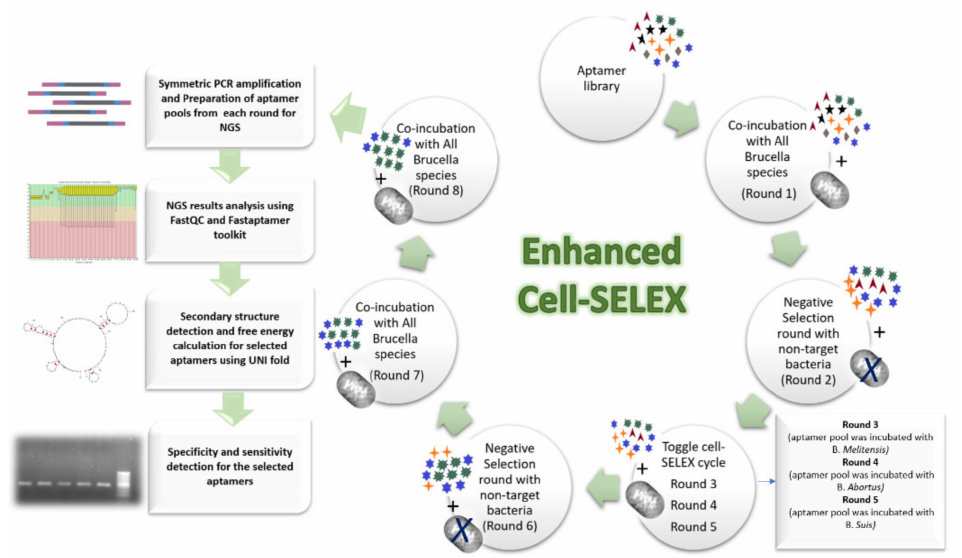
Figure 5. Schematic representation of the designed enhanced Cell-SELEX steps from initial aptamer pool until the selection of efficient aptamer